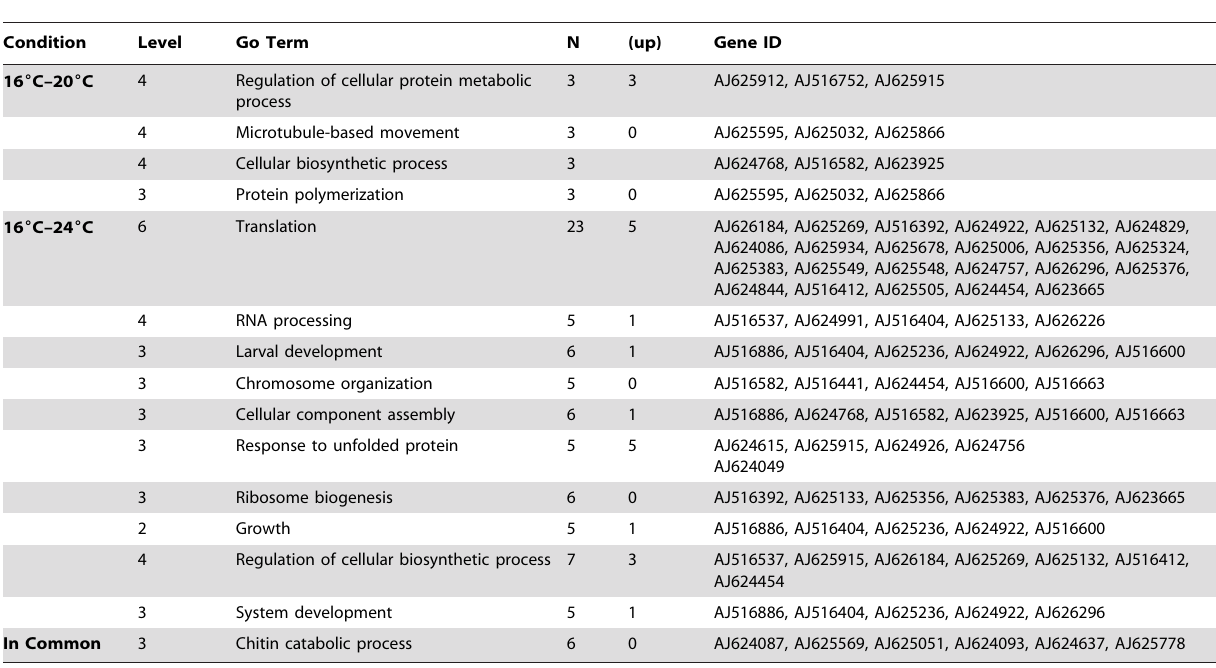
Table 2. GO term over-representation analysis of DEGs in the gills tissue of mussels exposed to heat stress.